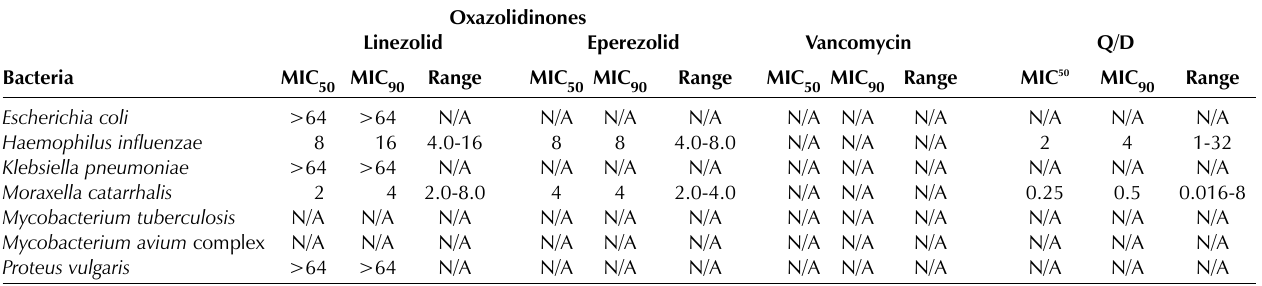
Oxazolidinones Linezolid